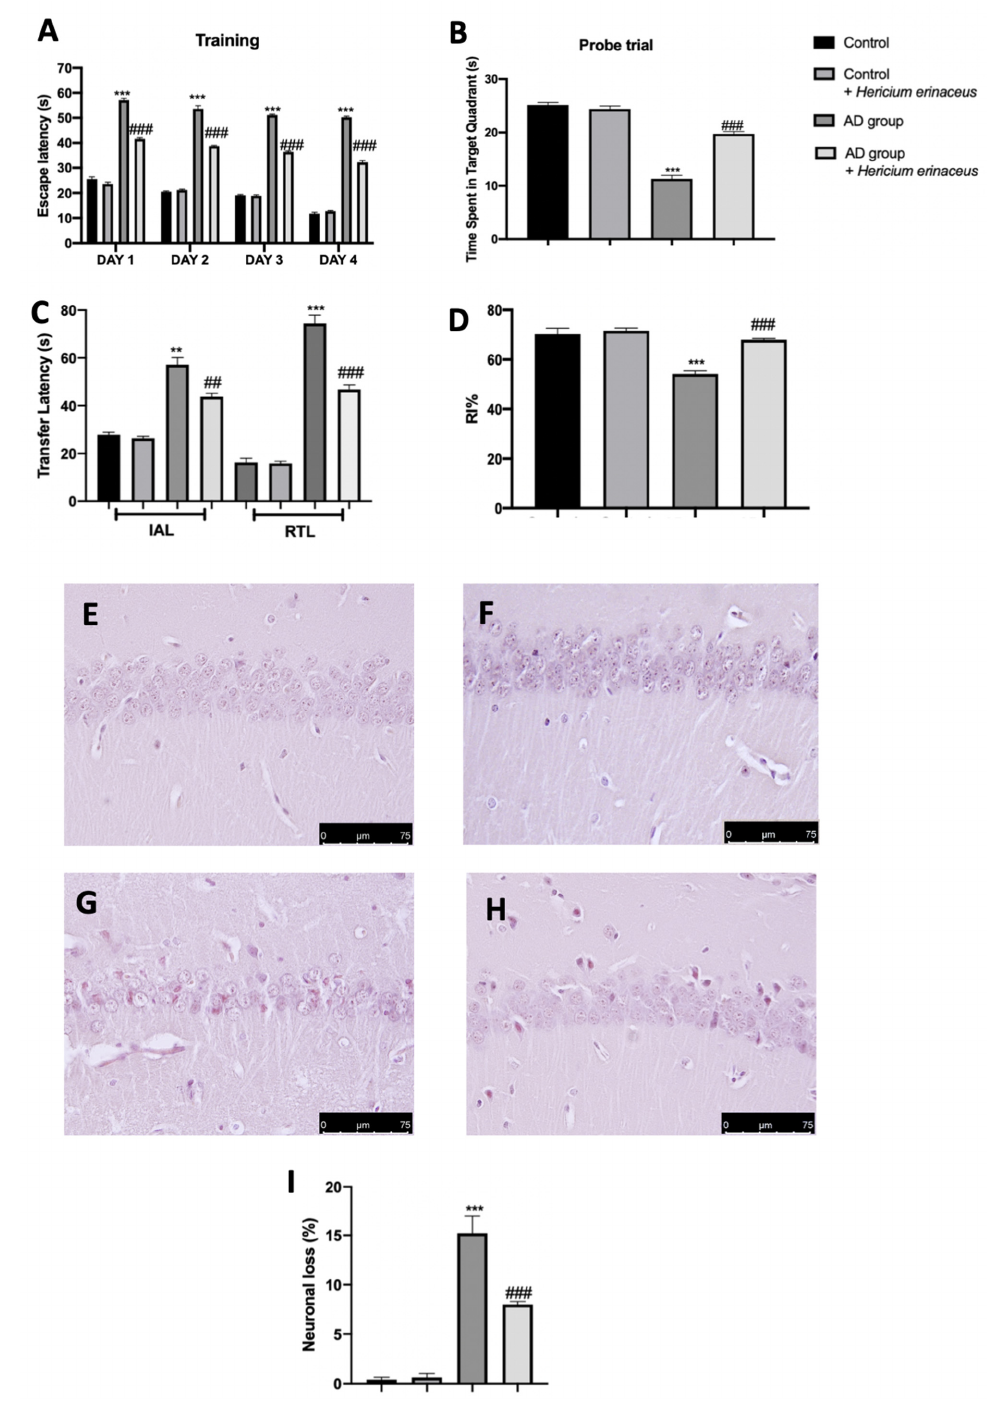
Figure 1. Hericium erinaceus administration decreased behavioral and hippocampal changes. Be- havioral analyses: Morris water maze test: training ( A ), probe trial ( B ); elevated plus maze test ( C ); novel object recognition test ( D ); histological analysis: control ( E ), control + Hericium erinaceus ( F ), AD group ( G ), AD group + Hericium erinaceus ( H ); quantitative analysis of necrotic neurons ( I ). For the behavioral and histological analyses, n = 5 animals from each group and for each analysis were employed. A p -value of less than 0.05 was considered significant. ** p < 0.01 vs. control, ## p < 0.01 vs. vehicle, *** p < 0.001 vs. control, ### p < 0.001 vs.